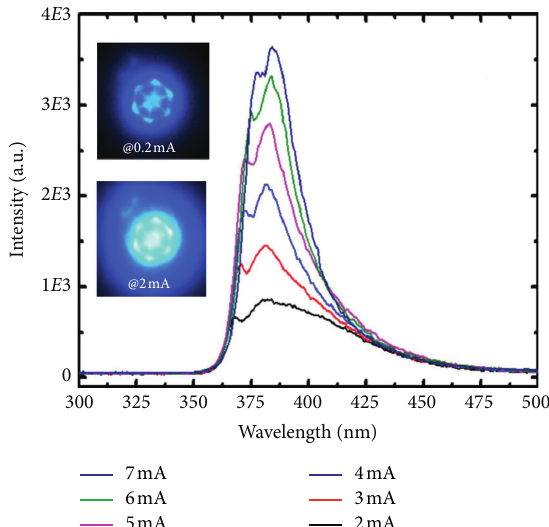
Figure 3: EL spectra of micropyramid UV LED working at various currents from 2 to 7 mA.